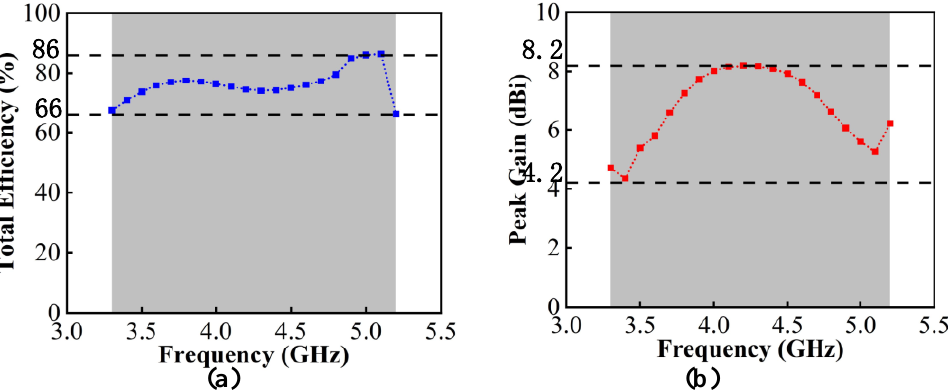
Figure 14. ( a ) Measured total efficiency. ( b ) Measured peak gain.